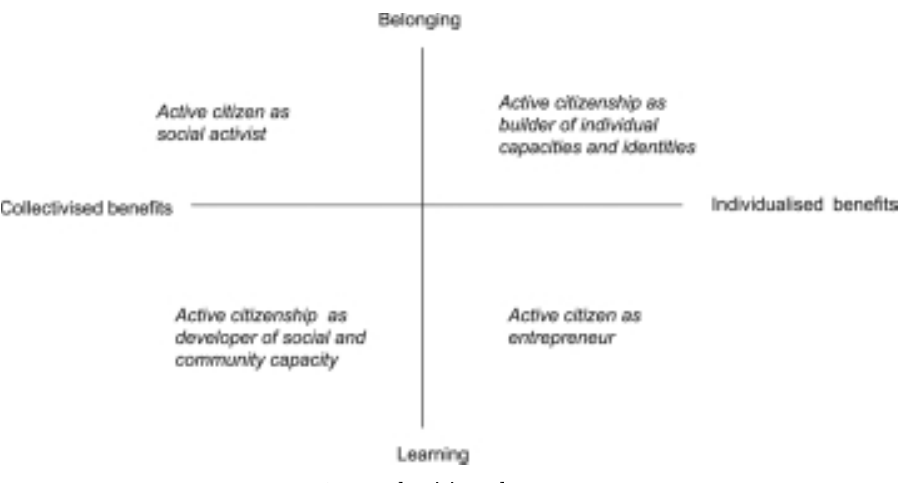
Figure 1. Beyond activist and